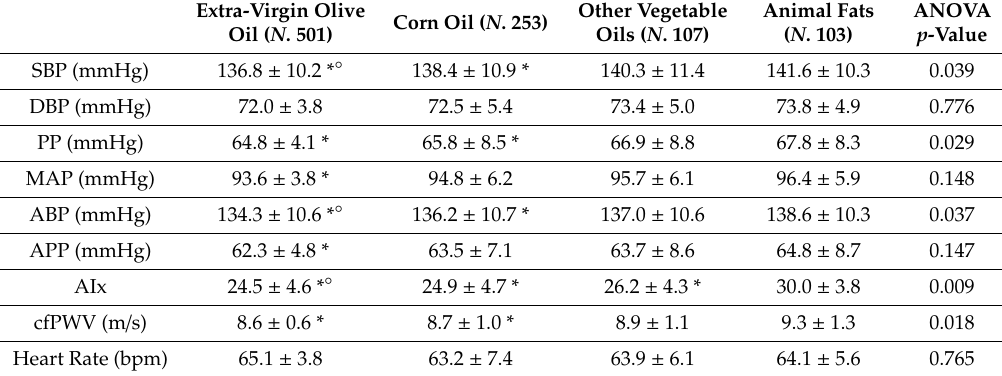
Table 3. Haemodynamic characteristics of subjects consuming di ff erent predominant cooking fats in every day meals.